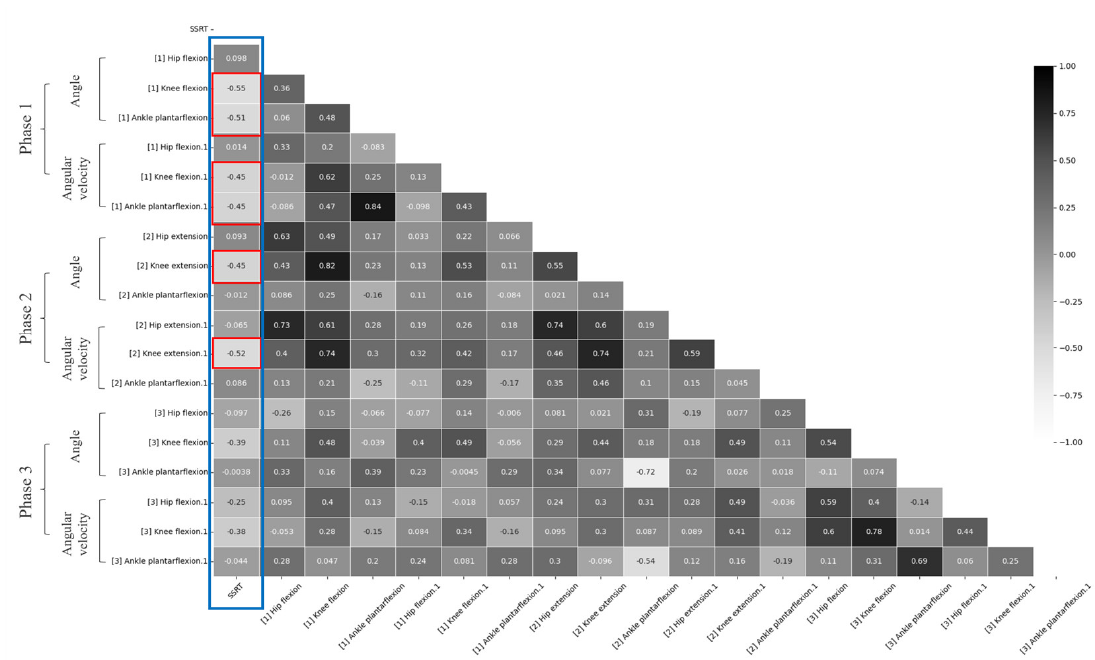
Figure 3. A heatmap depicting the correlation between SSRT and gait parameters for each phase; Blue box: correlation analysis between SSRT and gait parameters, Red box: gait parameters showing significant correlation with SSRT.